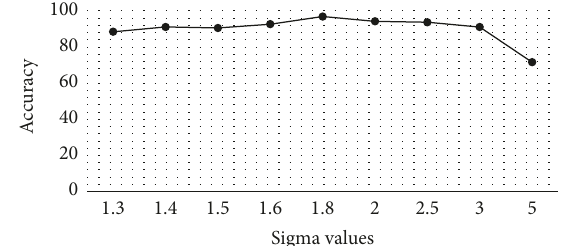
Figure 10: Accuracy comparison among different images.